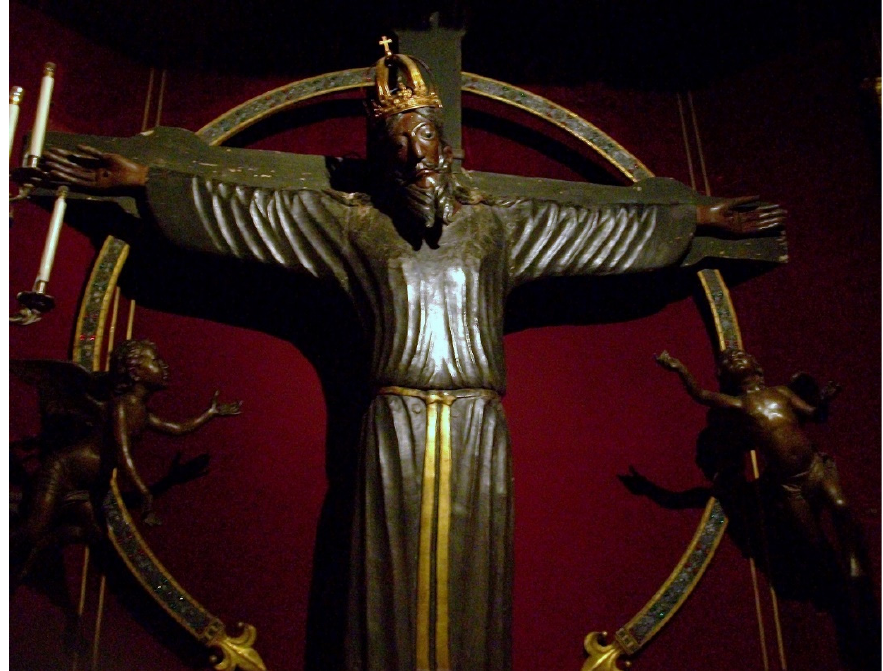
Figure 2. Volto Santo (8th/9th c.), Cathedral of Lucca, Italy. Photo Credit: Joanbanjo, own work, CC BY-SA 3.0, https://commons.wikimedia.org/w/index.php?curid=14326616 (accessed on 29 May 2022).